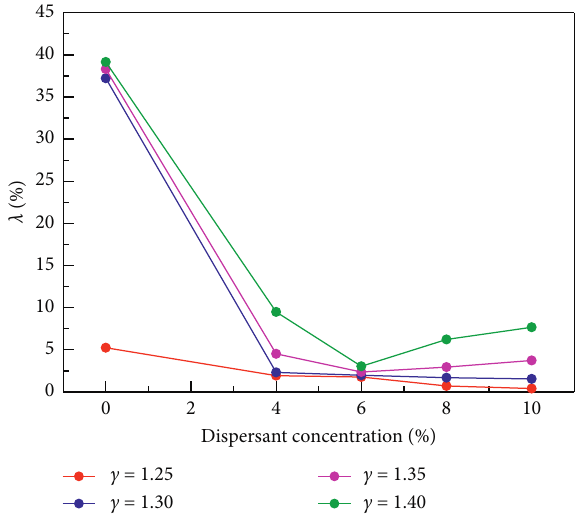
Figure 8: Effect of dispersant concentration on the empirical stickiness ratio, λ